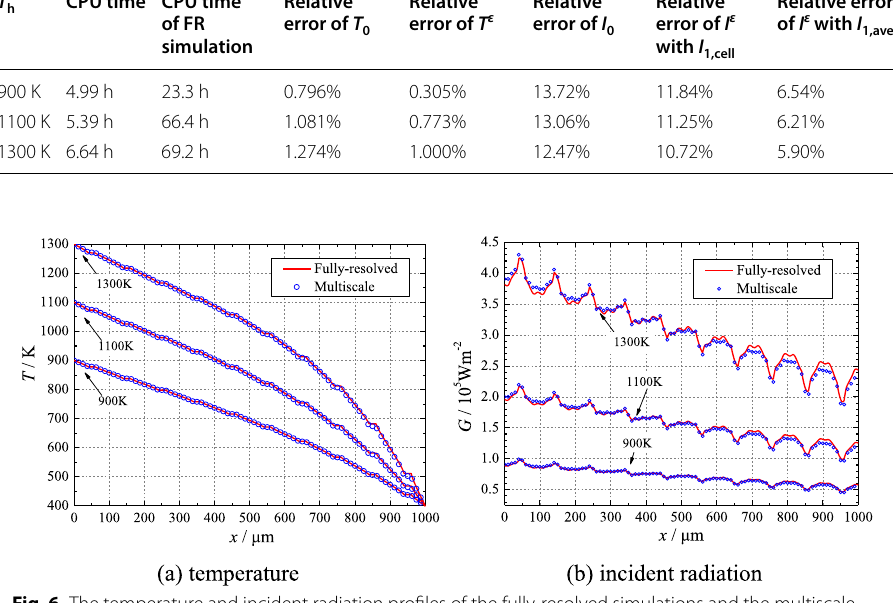
Fig. 6 The temperature and incident radiation profiles of the fully‑resolved simulations and the multiscale simulations on line y 0.05 =